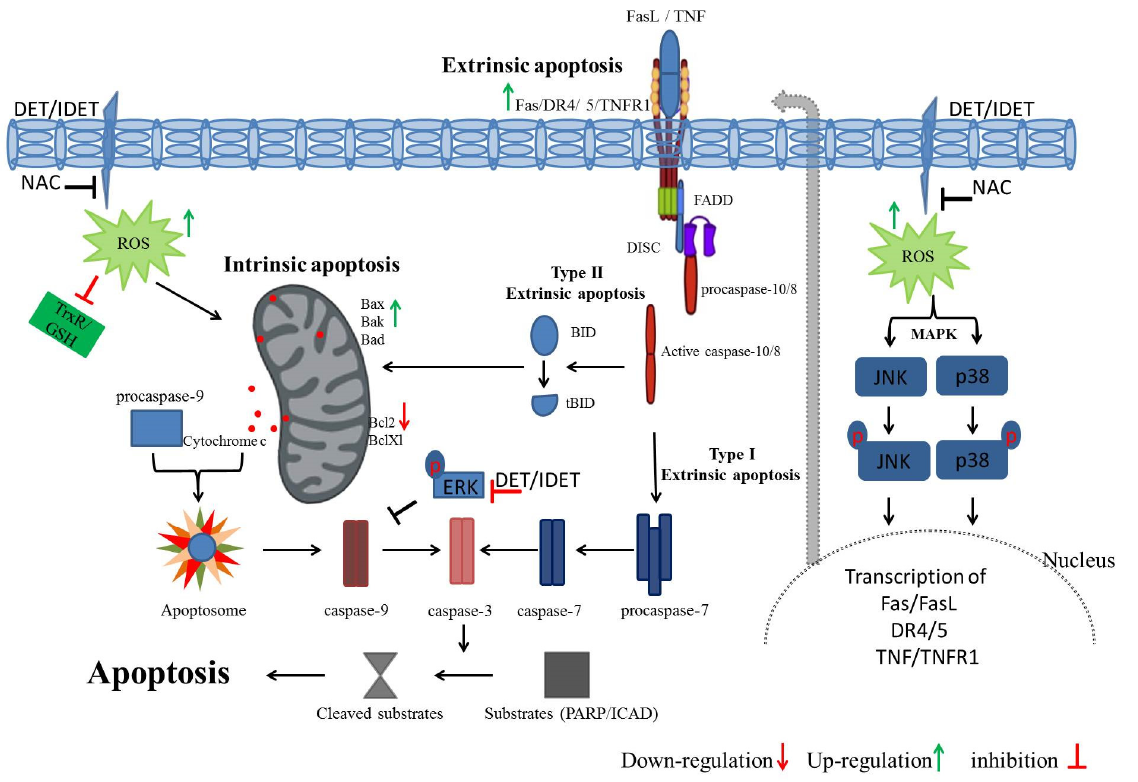
Figure 3. A schematic representation of DET/IDET-induced intrinsic and extrinsic apoptosis by ROS generation. DET/IDET induces ROS generation. Elevated ROS level activates JNK and p38 MAPK by phosphorylation. Activated p38 and JNK trigger the transcription of apoptosis-related genes, such as Fas/FasL, DR4/5, and TNF/TNFR1. Therefore, DET/IDET triggers the activation of extrinsic apoptosis and activates caspase-8 which, in turn, induces either tBid formation or downstream effector caspase-3 activation. Moreover, DET/IDET reduces thioredoxin reductase activity and intracellular level of glutathione, and induces intrinsic apoptosis by dissipating mitochondrial membrane